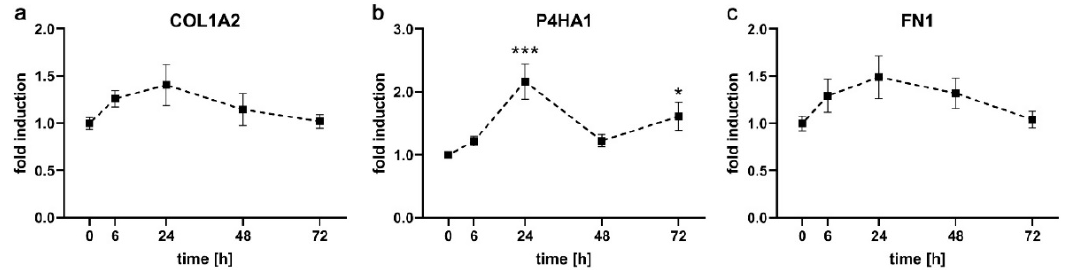
Figure 3. Expression kinetics of genes involved in formation of extracellular matrix in PDL-hTERT cells under compressive load. Expression of COL1A2 ( a ), P4HA1 ( b ) and FN1 ( c ) at the specified time points was determined via qRT-PCR, values were referenced to arithmetic means at T = 0 h and are shown as fold over non-treated controls at the respective time points ± SEM. n = 2, n = 6, * 0.01 ≤ p < 0.05, *** 0.0001 ≤ p < 0.01.